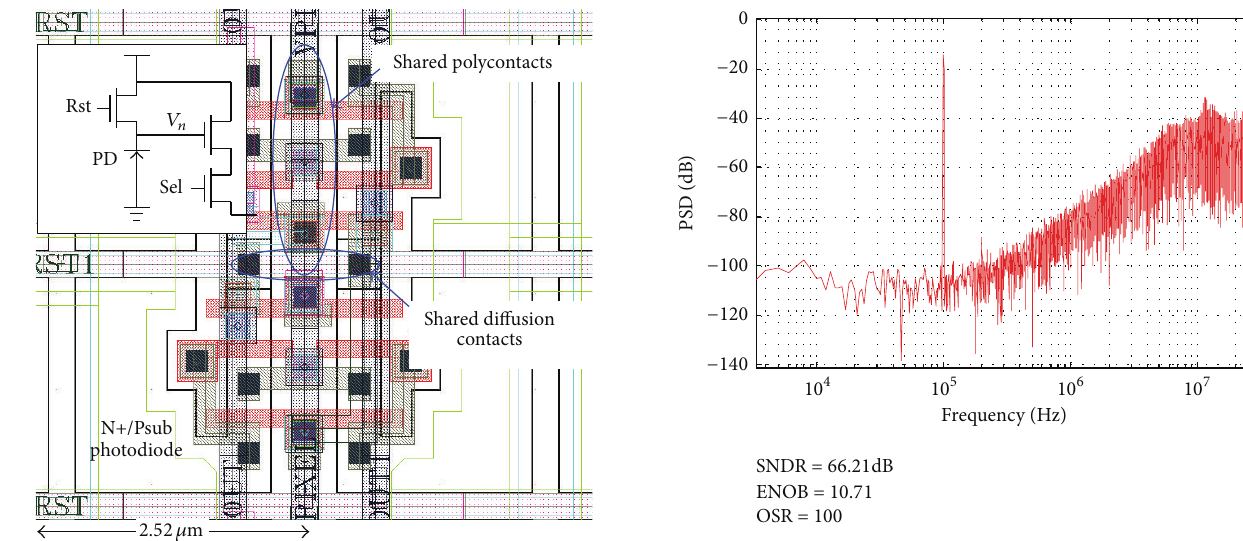
Figure 12: Measured power spectrum density of the proposed CTSD modulator output bit stream (50,000 points